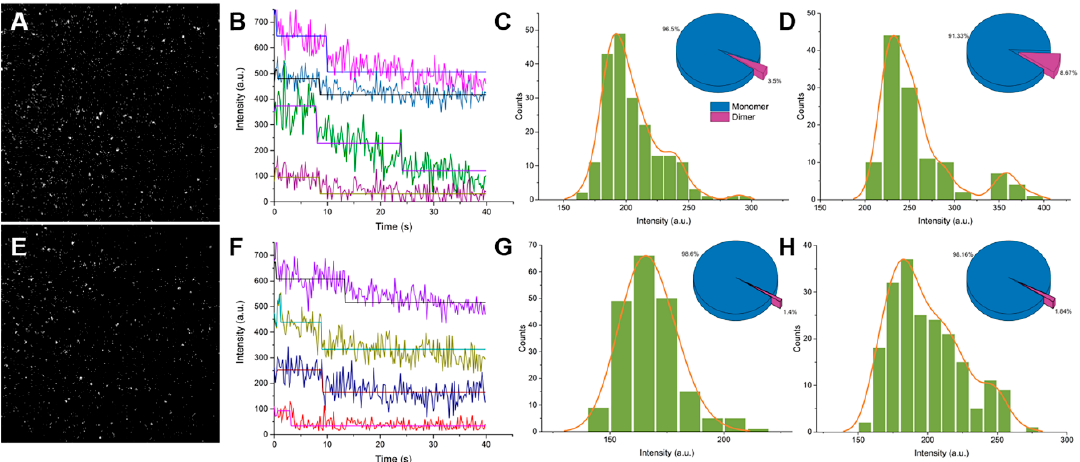
Figure 1. Single-molecule imaging of GFP and GFP-A206K. ( A ) Typical single-molecule fluorescence imaging of GFP on the coverslip surface. ( B ) One- and two-step photobleaching of GFP. Traces are arbitrarily shifted along the y-axis for display clarity. ( C , D ) Fluorescence intensity and photobleaching step distributions of GFP spots in 0.17 µ g/mL and 0.57 µ g/mL solutions, respectively. ( E ) Typical single-molecule fluorescence imaging of GFP-A206K on the coverslip surface. ( F ) One- and two-step photobleaching of GFP-A206K. Traces are arbitrarily shifted along the y-axis for display clarity. ( G , H ) Fluorescence-intensity and photobleaching step distributions of GFP-A206K spots in 0.17 µ g/mL and 0.57 µ g/mL solutions, respectively.